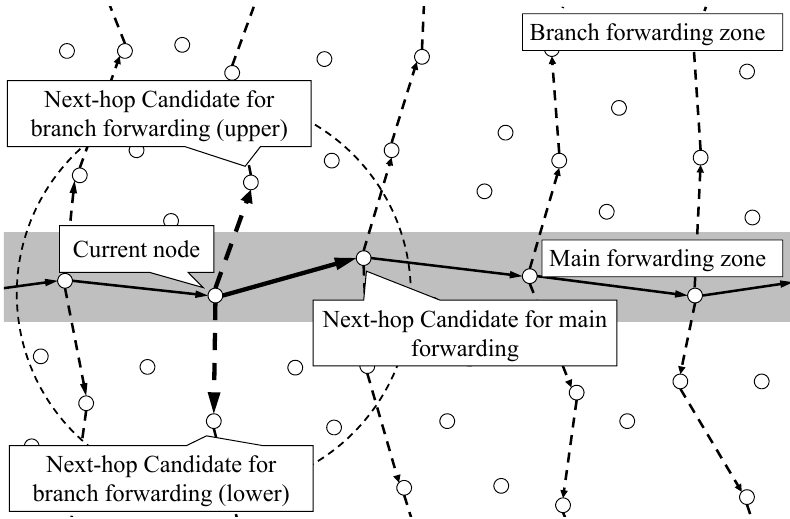
Figure 7. Point selection for main and branch